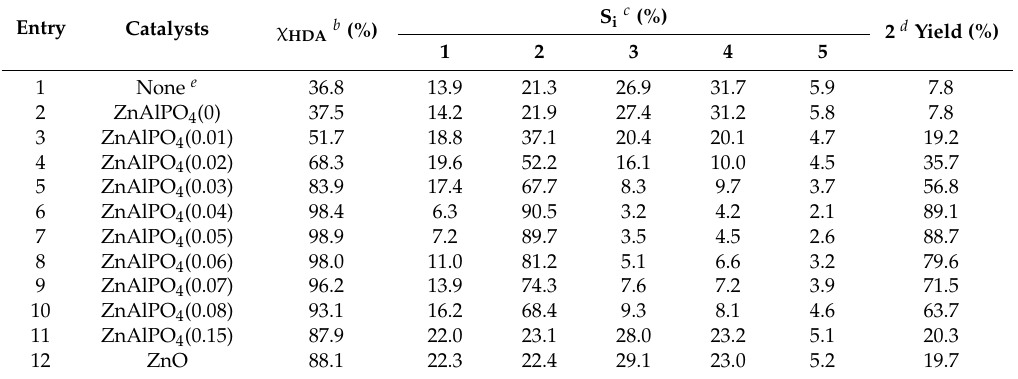
Table 1. Experiment results of the synthesis of dibutyl hexane-1,6-dicarbamate from 1,6-hexanediamine (HDA), urea and butanol using Zn/AlPO 4 with different molar ratios as catalyst a .